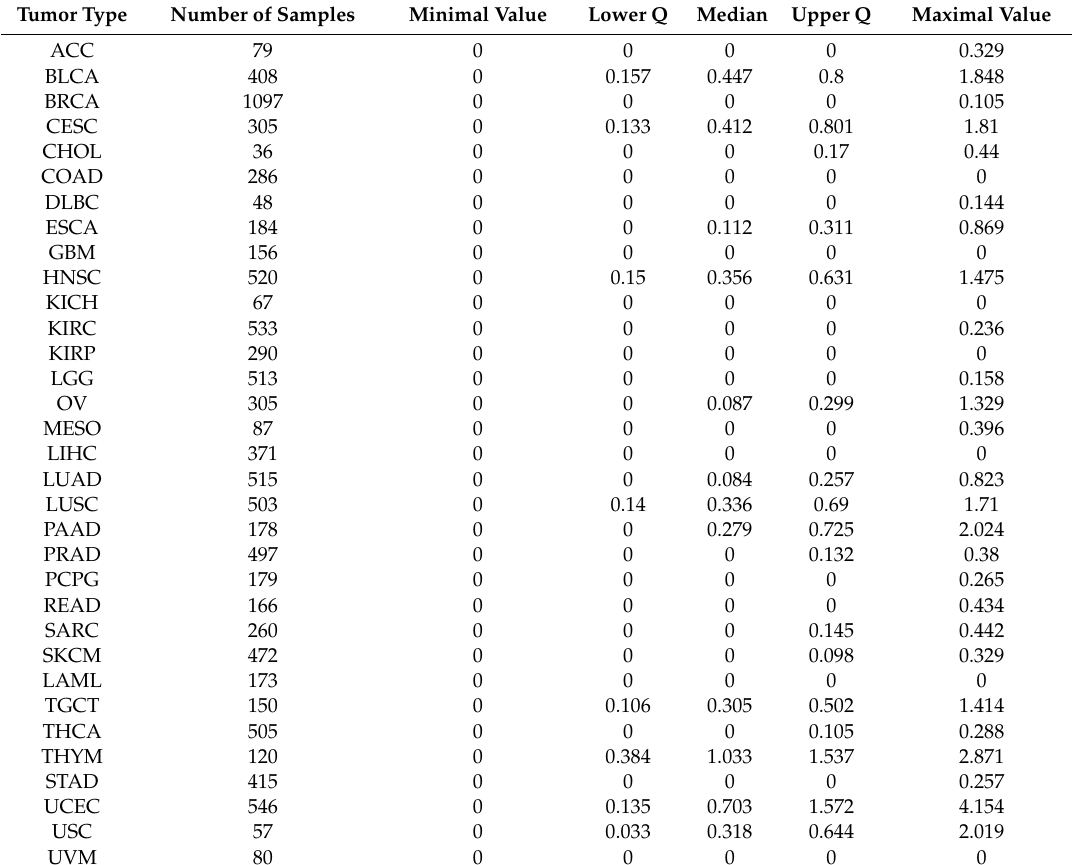
Table 2. Expression values of CGB2 in di ff erent tumor types according to